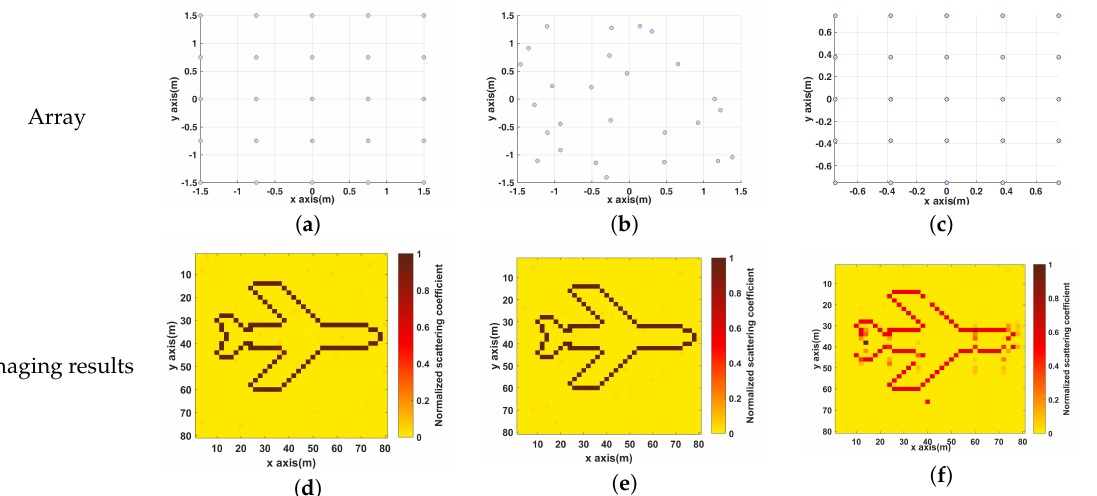
Figure 11. Imaging results under different transmitting array configurations ( a – c ) Different transmitting array configurations; ( d – f ) Imaging results.